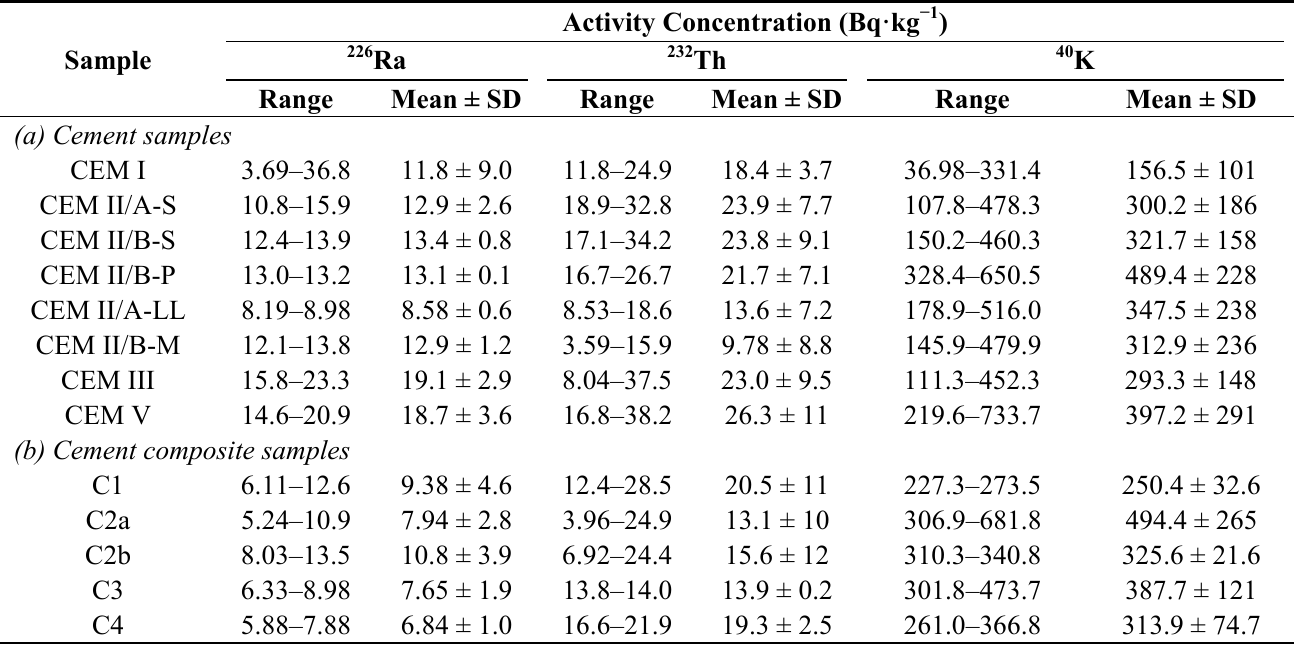
Table 4. Activity concentration of 226 Ra, 232 Th and 40 K in studied cements and cement